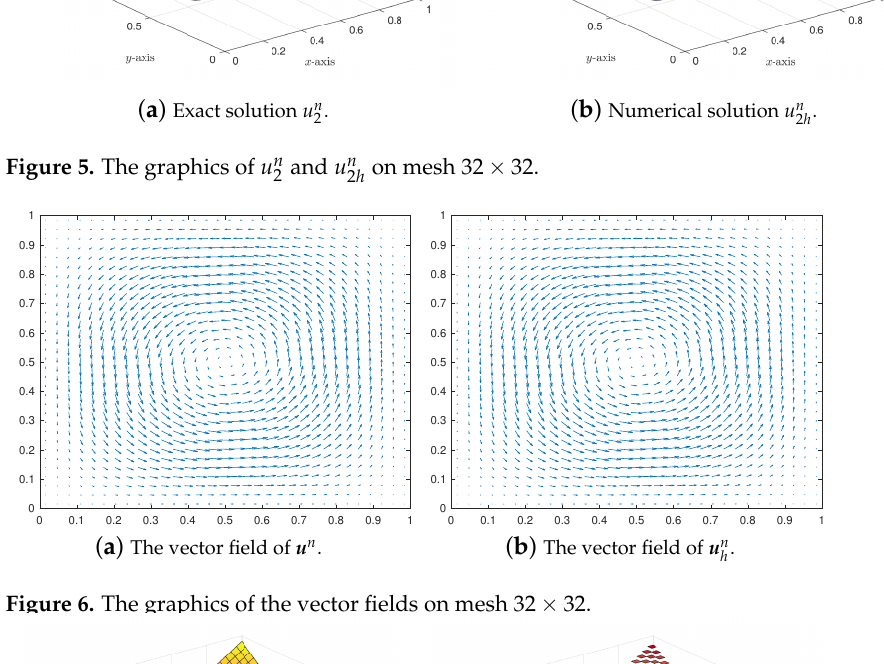
Figure 6. The graphics of the vector fields on mesh 32